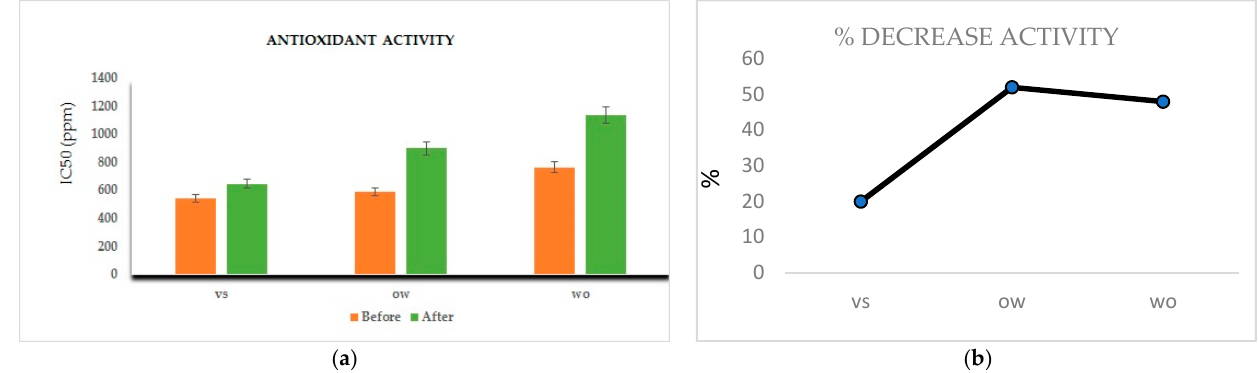
Figure 4. Antioxidant activity of the cream before and after ( a ) storage and % decrease activity ( b ).